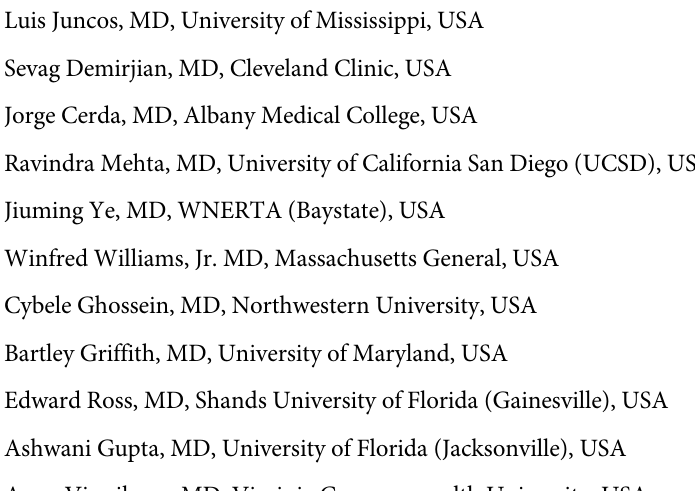
S8 Fig. Kaplan-Meier curve of mortality at Day 60 of riCa and non-riCa subgroups in the Control patients (log-rank p-value = 0.85). (TIF) S9 Fig. Kaplan-Meier analysis of mortality at Day 60 for riCa and non-riCa subgroups in the SCD treated patients (log-rank p-value = 0.03). (TIF) S1 Protocol. SCD-003_protocol_v1.4.